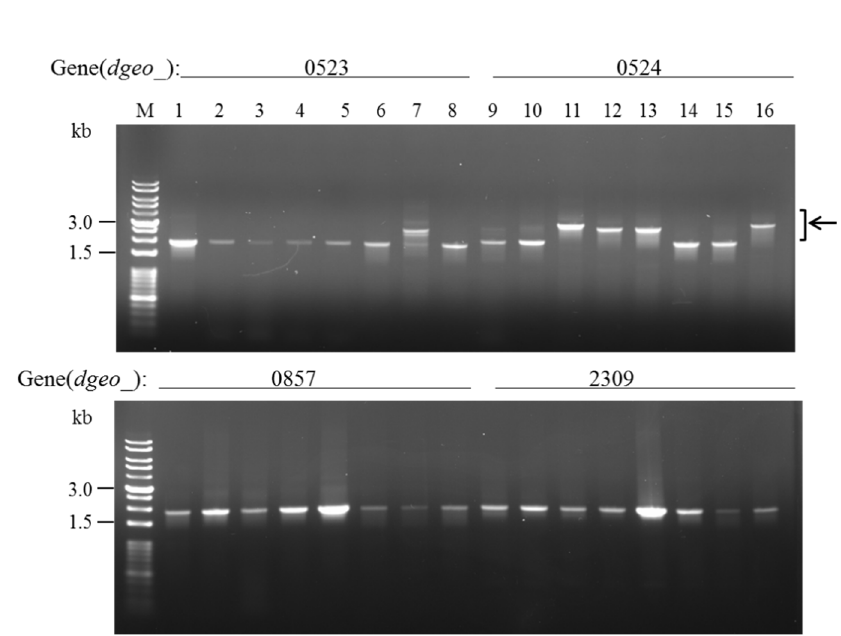
Figure 2. PCR detection of transposition loci on four target genes for carotenoid biosynthesis within